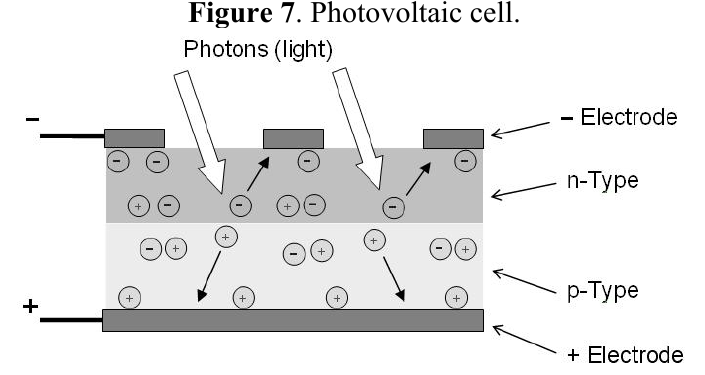
Figure 7 . Photovoltaic cell.